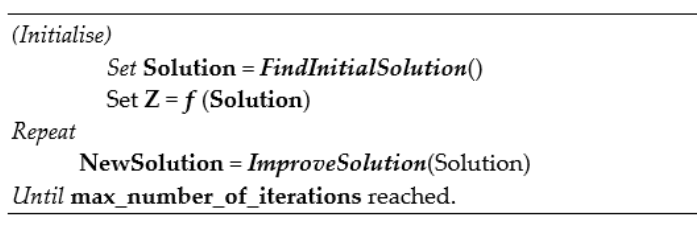
Figure 2. Flowchart of the proposed two -phase algorithm.